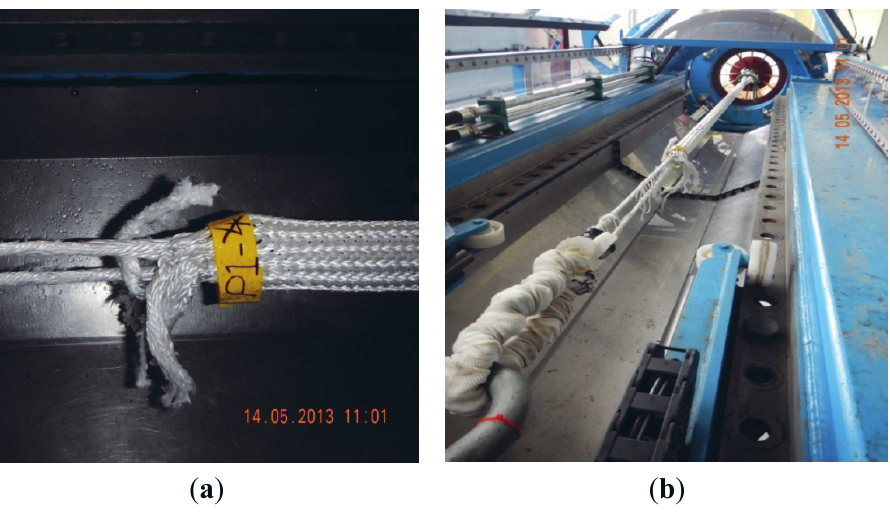
Figure 10. (a) Breaking load test failure detail; (b) breaking load test tether following failure in DMaC test